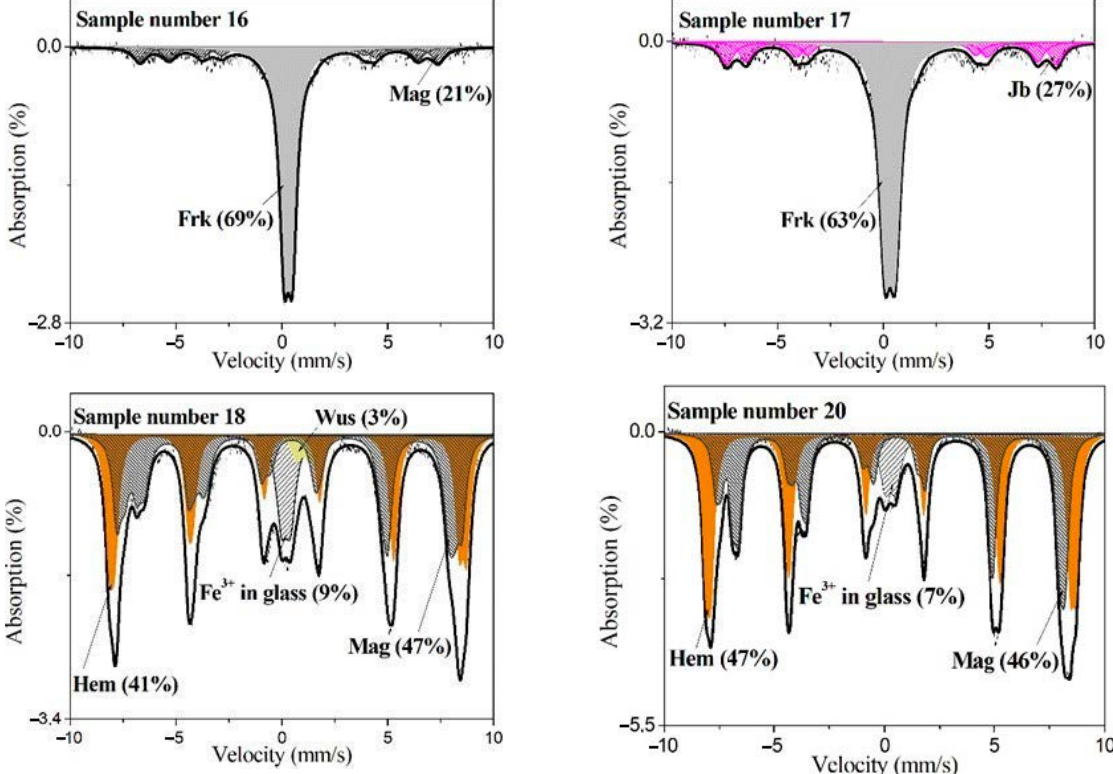
Figure 14. Mössbauer spectra obtained for steel dusts (No. 16, 17, and 18) and sinter dust (No. 20). Fitted subspectra, their assignments and contribution are visible on the spectra; Frk—franklinite, Hem—hematite, Mag—magnetite, Wus—wüstite, Jb—jacobsite. Absolute errors are estimated at ± 1% for components